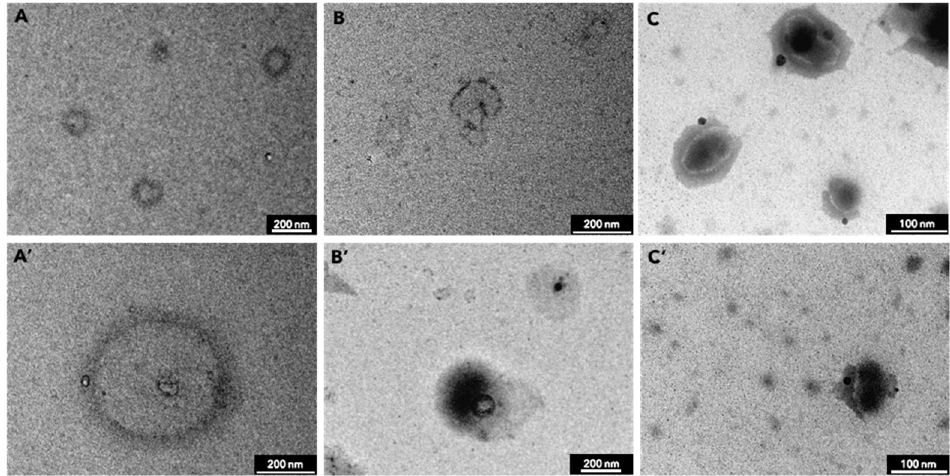
Figure 3. TEM photomicrographs of blank SLN ( A , A’ ) and loaded SLN with 0.5% ( w / w , B , B’ ) and 1% ( w / w , C , C’ ) β -carotene,